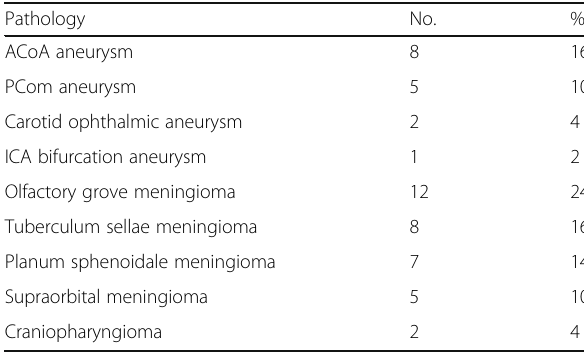
Table 1 Pathological